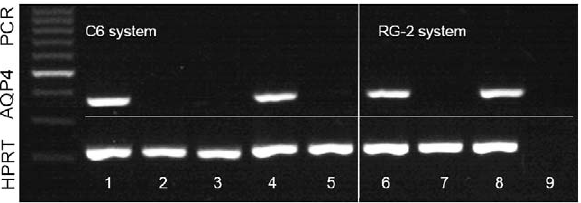
Figure 4. Representative RT-PCR on an agarose gel showing bands corresponding to AQP4 mRNA and the internal standard HPRT. AQP4 mRNA is only expressed in normal rat brain (lane 1 and 6) and intracerebral implanted C6 and RG-2 cell tumor (lane 4 and 8) compared to the C6 and RG-2 cell culture (lane 2 and 7) as well as C6 implanted extracranial and flank tumor (lane 3 and 5). Lane 9 shows the negative H 2 O control.